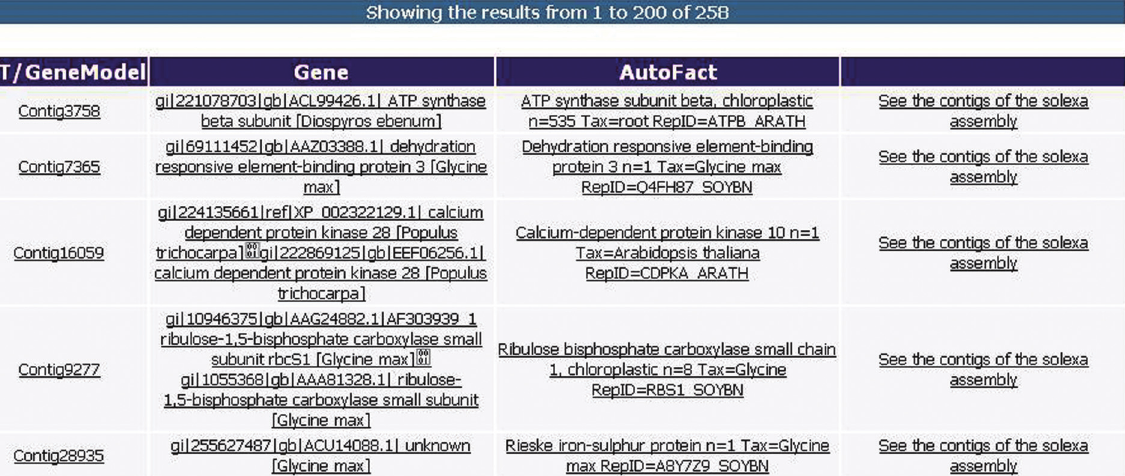
Figure4 -Webinterfaces.(A)ResultsfortheSuperSAGEanalysis.Foreachuniquetagareavailable:tagcountincontrolandtreatedlibraries(columns3 and4),fold-change(column5),p-value(column6),thecorrespondentgene(column7),alignmentinformation(columns8,9and10)andgeneannotation (column 11). (B) Results for one subtractive library of the project, showing all genes found in the library and their respective annotation. The interface al- lows the user to search using a keyword in the annotation